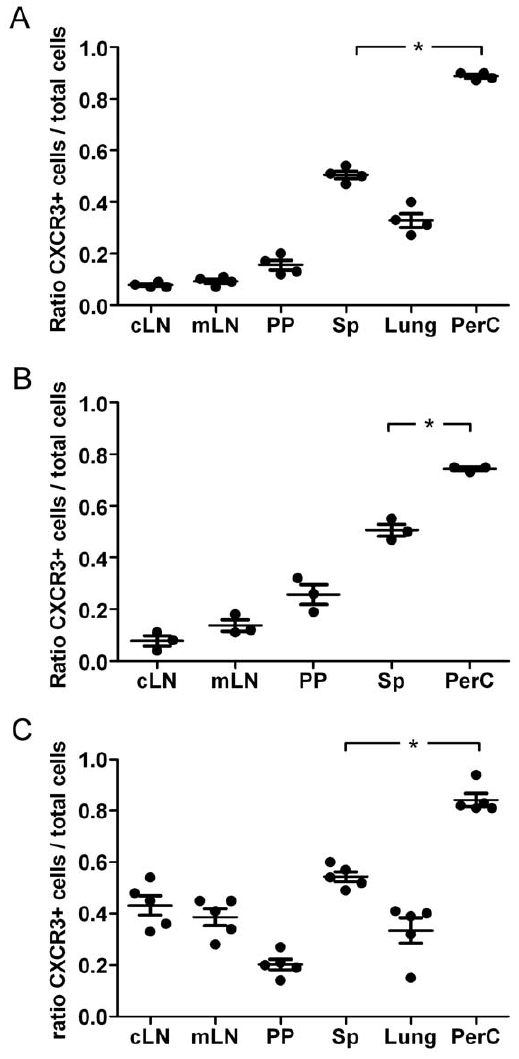
Figure 2. CXCR3 + CD4 + T cells preferentially migrate to the PerC. CXCR3 + and CXCR3 2 CD4 + T isolated from donor animals were differentially labeled with CFSE or CMTMR, and mixtures containing equal numbers of cells were injected intravenously into naı¨ve recipients. Eighteen hours after transfer, the ratio of transferred CXCR3 + cells to total transferred (CXCR3 + + CXCR3 2 ) cells was determined in different organs by flow cytometry. (A) CD4 + CXCR3 + and CD4 + CXCR3 2 T cells isolated from Sp of donor BALB/c mice. (B) CD4 + CXCR3 + and CD4 + CXCR3 2 T cells isolated from PerC of donor BALB/c mice. (C) CD4 + CXCR3 + CD62L low CD44 high and CD4 + CXCR3 2 CD62L low CD44 high T cells isolated from Sp of C57BL/6 donor mice. Dots represent the ratio for the individual animals analyzed. Similar results were obtained in three independent experiments. Horizontal lines indicate the mean for the group, error bars correspond to the SEM. (*) Statistical significance at P , 0.001. cLN cervical lymph node; mLN, mesenteric lymph node; PP Peyer’s patches; Sp, spleen; PerC, peritoneal cavity.